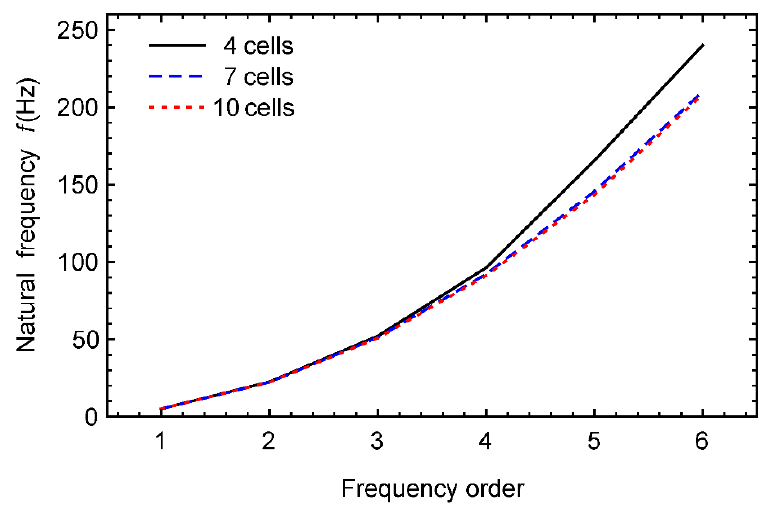
Figure 9. Natural frequencies of the fluid-conveying periodic pipe with different numbers of cells.